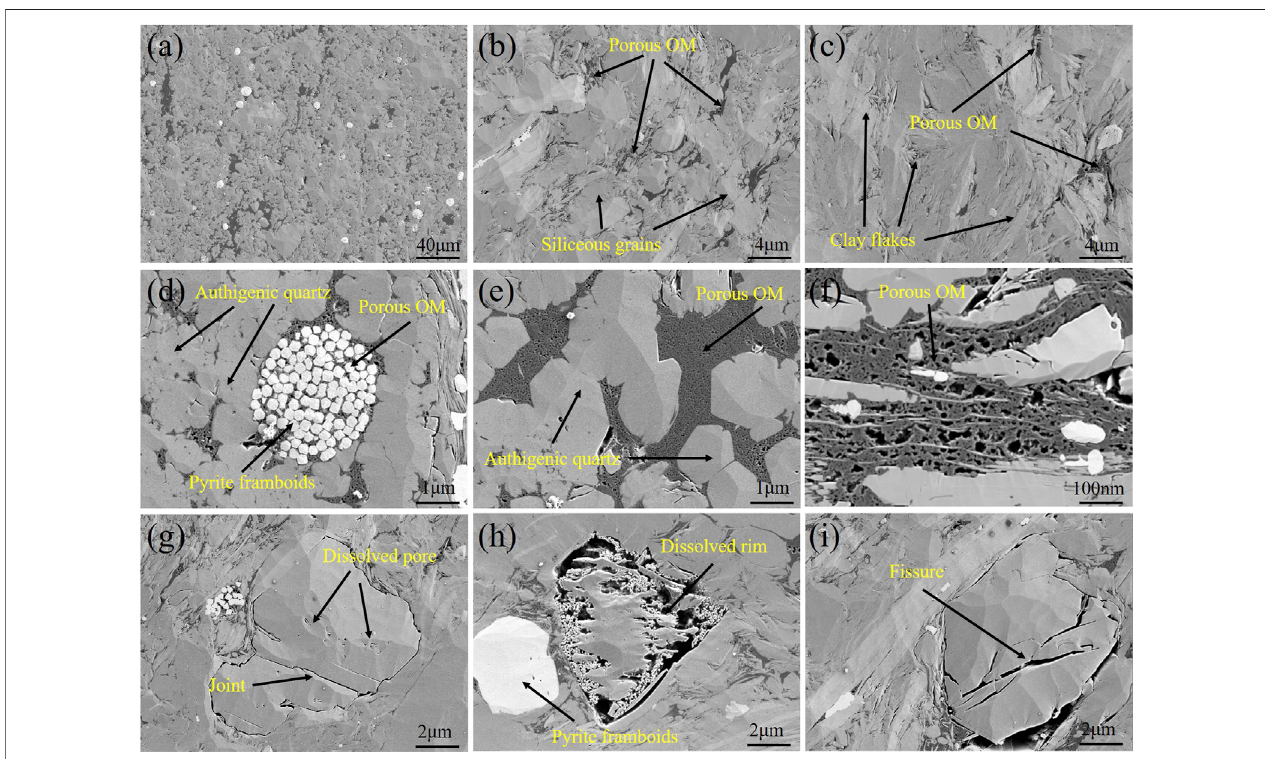
FIGURE 9 | FIB-SEM images of the Lower Silurian shales. (A – C) OM mixed with matrixes as stripes and wisp (#S3), (D,E) porous OM inside of pyrite framboids or mixed with authigenic quartz (#S4 and #S5), (F) porous OM with cellular shapes (#S6), (G) dissolved pores as isolated points (#S4), (H) dissolved rim on the surface of feldspar (#S7), and (I) fi ssures inside grain fragments